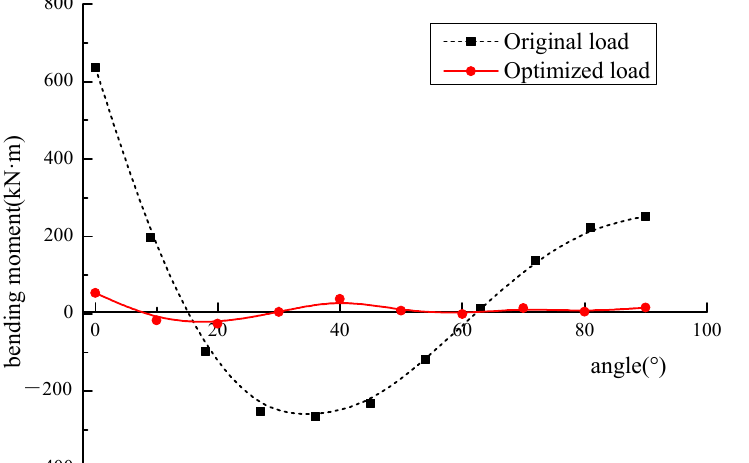
Figure 8. Comparison of bending moments caused by conventional load and adjusted load.